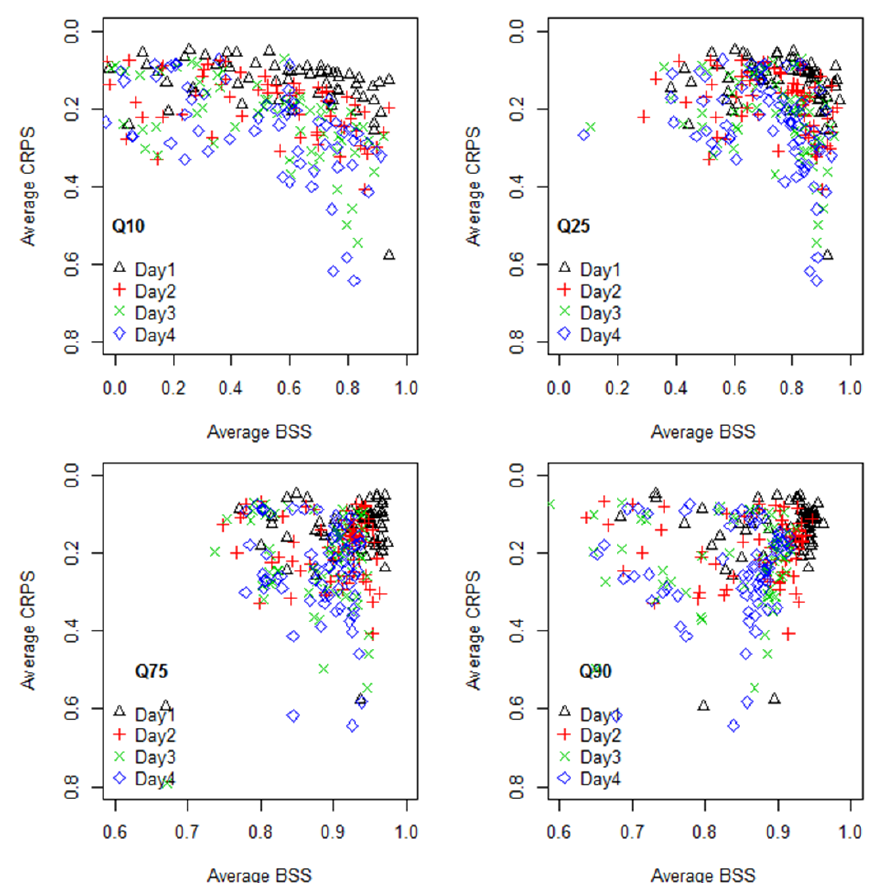
Figure 10. Comparing the performance of combination 30 (err24, err48, rr24, rr48) as measured by Brier skill score and as measured by the continuous ranked probability score. Each data point corresponds with a gauge at a certain lead time. Since the CRPS’ perfect score equals zero, the y axis has been